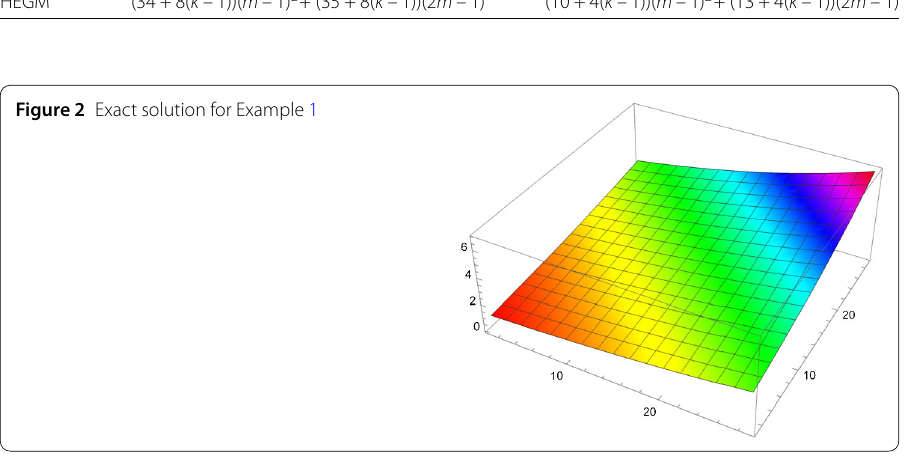
Figure 3 Approximate solution for Example 1 when h = τ = 1